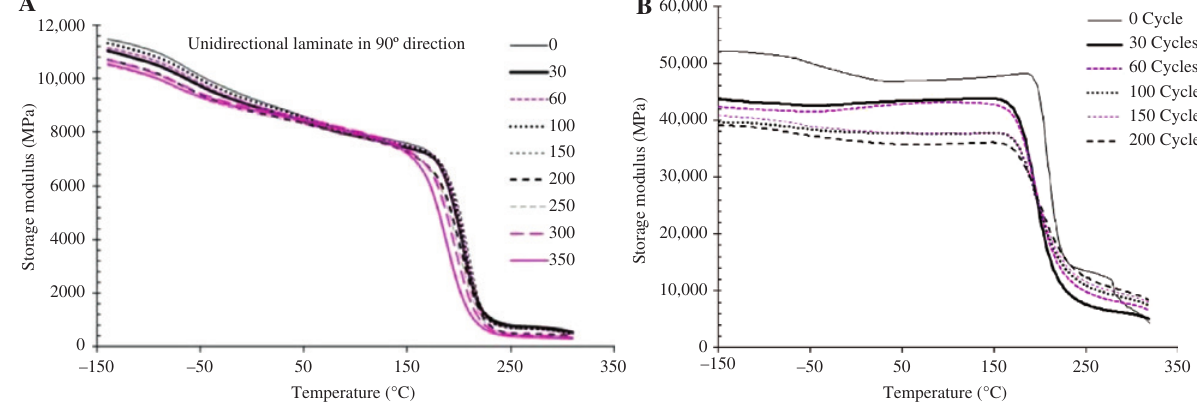
Figure 5: Effect of thermal cycling on the storage modulus of (A) UD and (B) cross-ply fabric composites in the 90 °